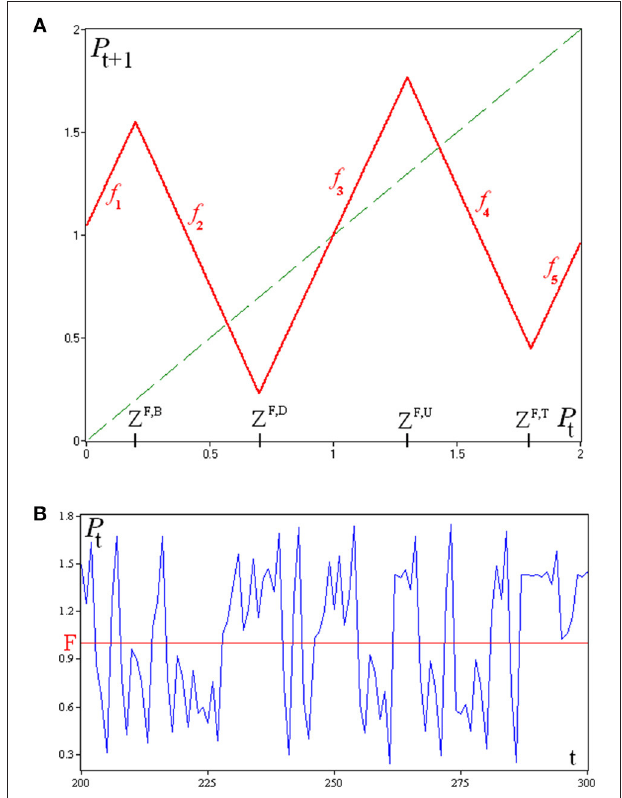
FIGURE 2 | The shape of the map (A) and a timeplot (B) obtained by using the following set of parameters: a = 2.6, c = 0.6, f = 2, F = 1, Z F , B = 0.2, Z F , D = 0.7, Z F , U = 1.3, Z F , T = 1.8.